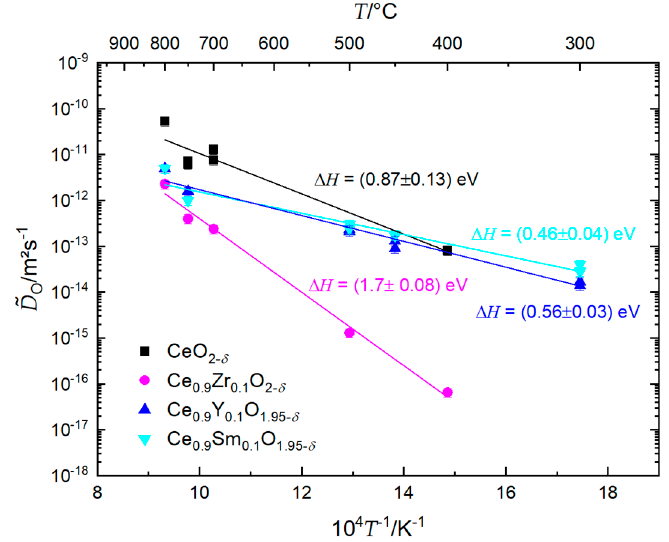
Figure 4. Determined chemical oxygen diffusion coefficients (cid:101) D O in ceria containing 10 at-% of dopants (Y, Sm, Zr) and in nominally un-doped ceria samples in the temperature range from T = 300 °C to T = 800 °C, together with calculated activation enthalpies.